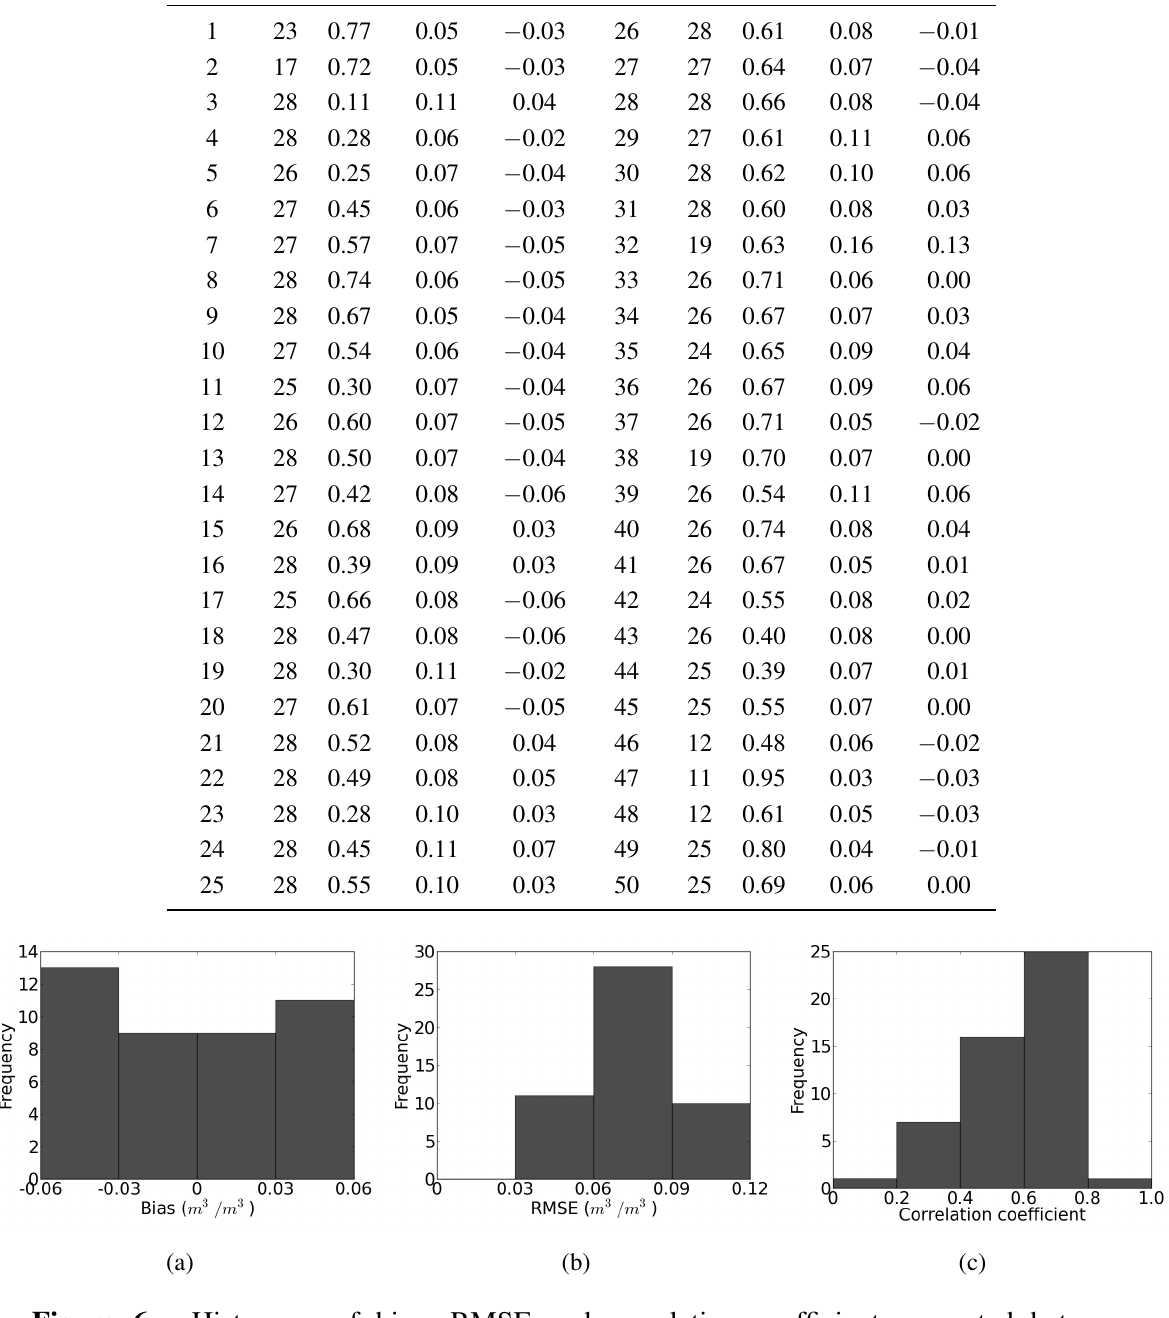
Figure 6. Histogram of bias, RMSE and correlation coefficient computed between soil moisture retrieved using CT and measured soil moisture. ( a ) Histogram of bias, ( b ) Histogram of RMSE, ( c ) Histogram of